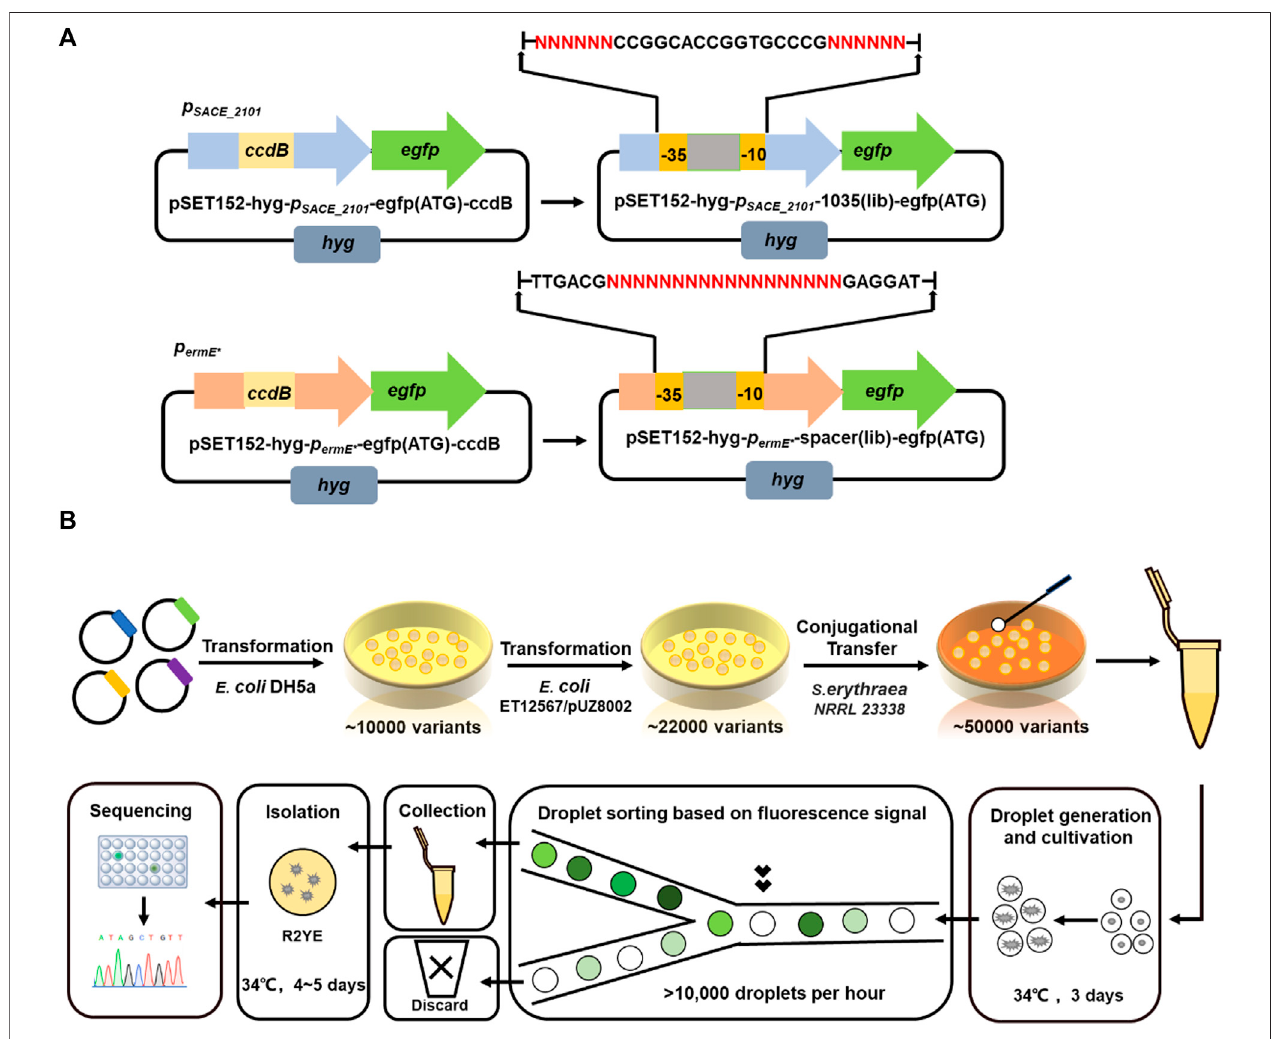
FIGURE 2 | Promoter engineering and screening using droplet-based micro fl uidic platform. (A) Schematic diagrams of two plasmid libraries pSET152- p SACE_2101 – 1035 (lib)-egfp (ATG) and pSET152- p ermE* -spacer (lib)-egfp (ATG). “ NNN ” indicated the varied regions. (B) Work fl ow of promoter library construction and droplet micro fl uidic based high-throughput screening.